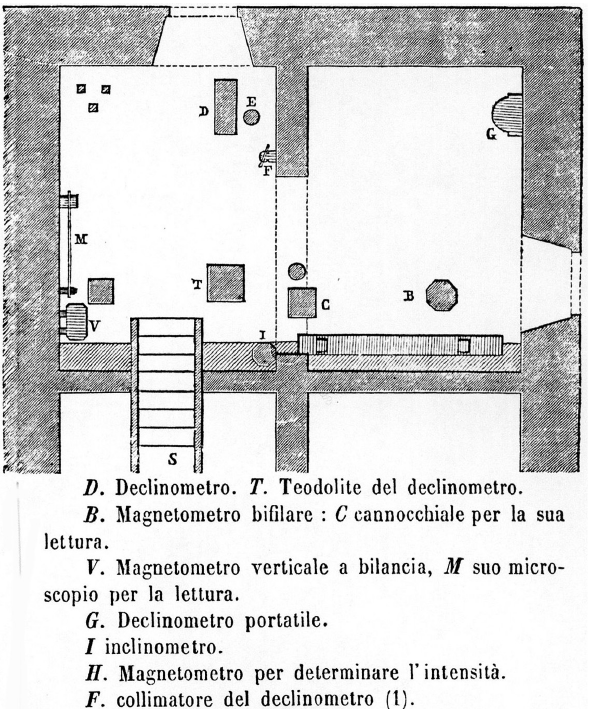
Figure 8. Plan of the magnetic observatory room showing the po- sition of the instruments (Secchi, 1861).